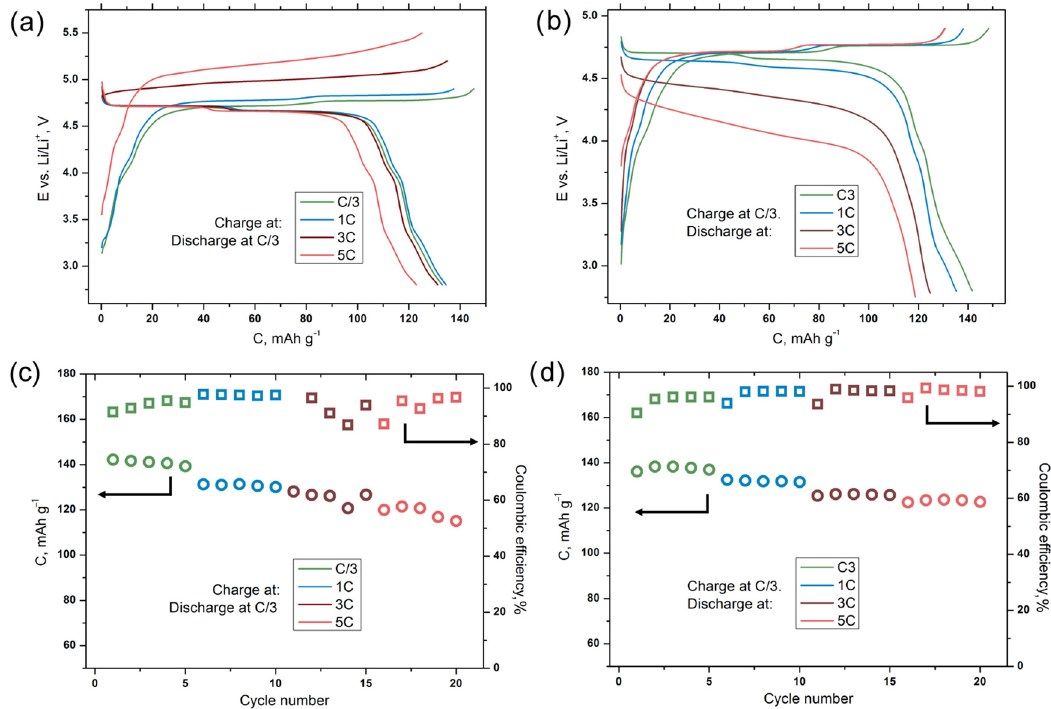
Figure 6. Results of the C-rate retention tests for the LiNi 0.5 Mn 1.5 O 4 cathode in half-cells with 3 М LiPF 6 in EC:DEC:DMC = 1:1:1 (Standard 3 M) electrolyte. ( a , c ) “Fast charge–slow discharge” regime; LiPF 6 in EC:DEC:DMC = 1:1:1 (Standard 3 M) electrolyte. ( a , c )“Fast charge–slow discharge” regime;( b , d ) “slow charge–fast discharge” regime. ( b , d ) “slow charge–fast discharge”